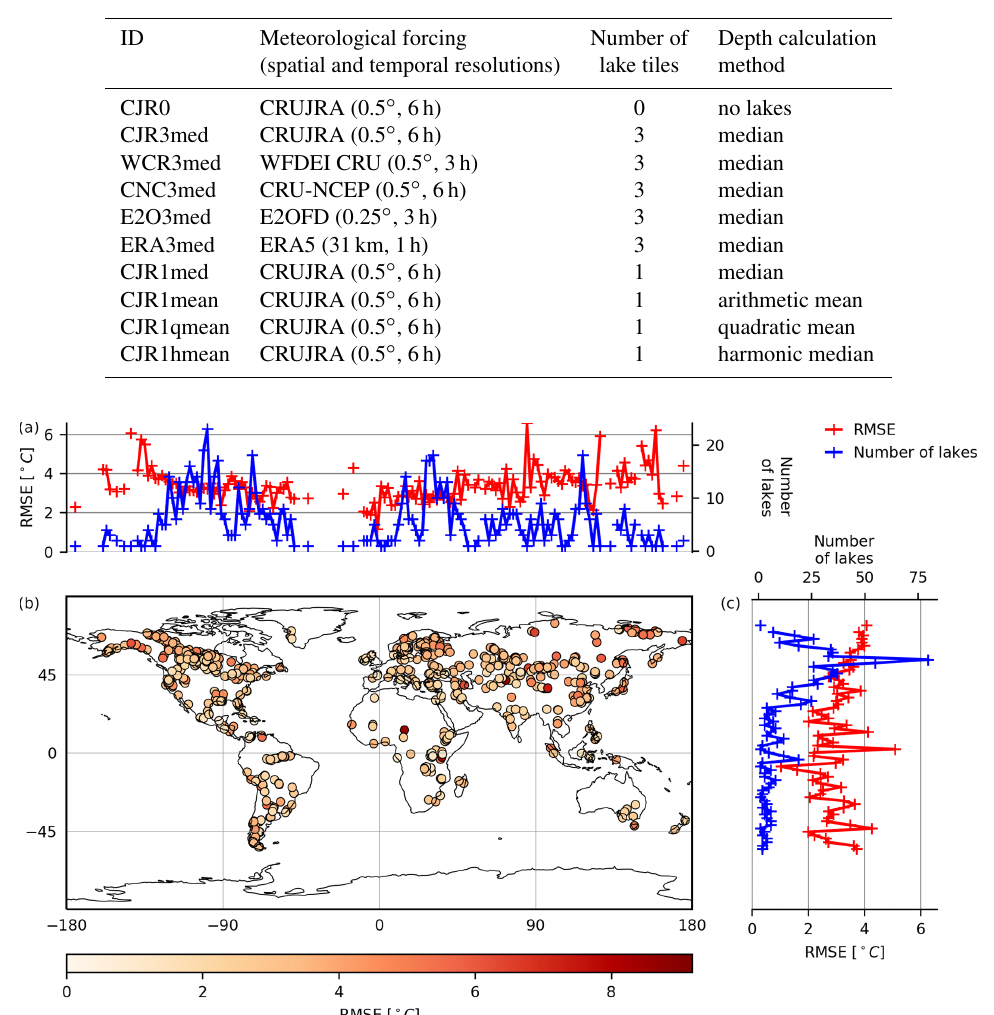
Table 1. List of the 10 ORCHIDEE-FLake simulations performed at global scale, differing from the atmospheric forcing used and the number of lake tiles considered in the ORCHIDEE grid cell.